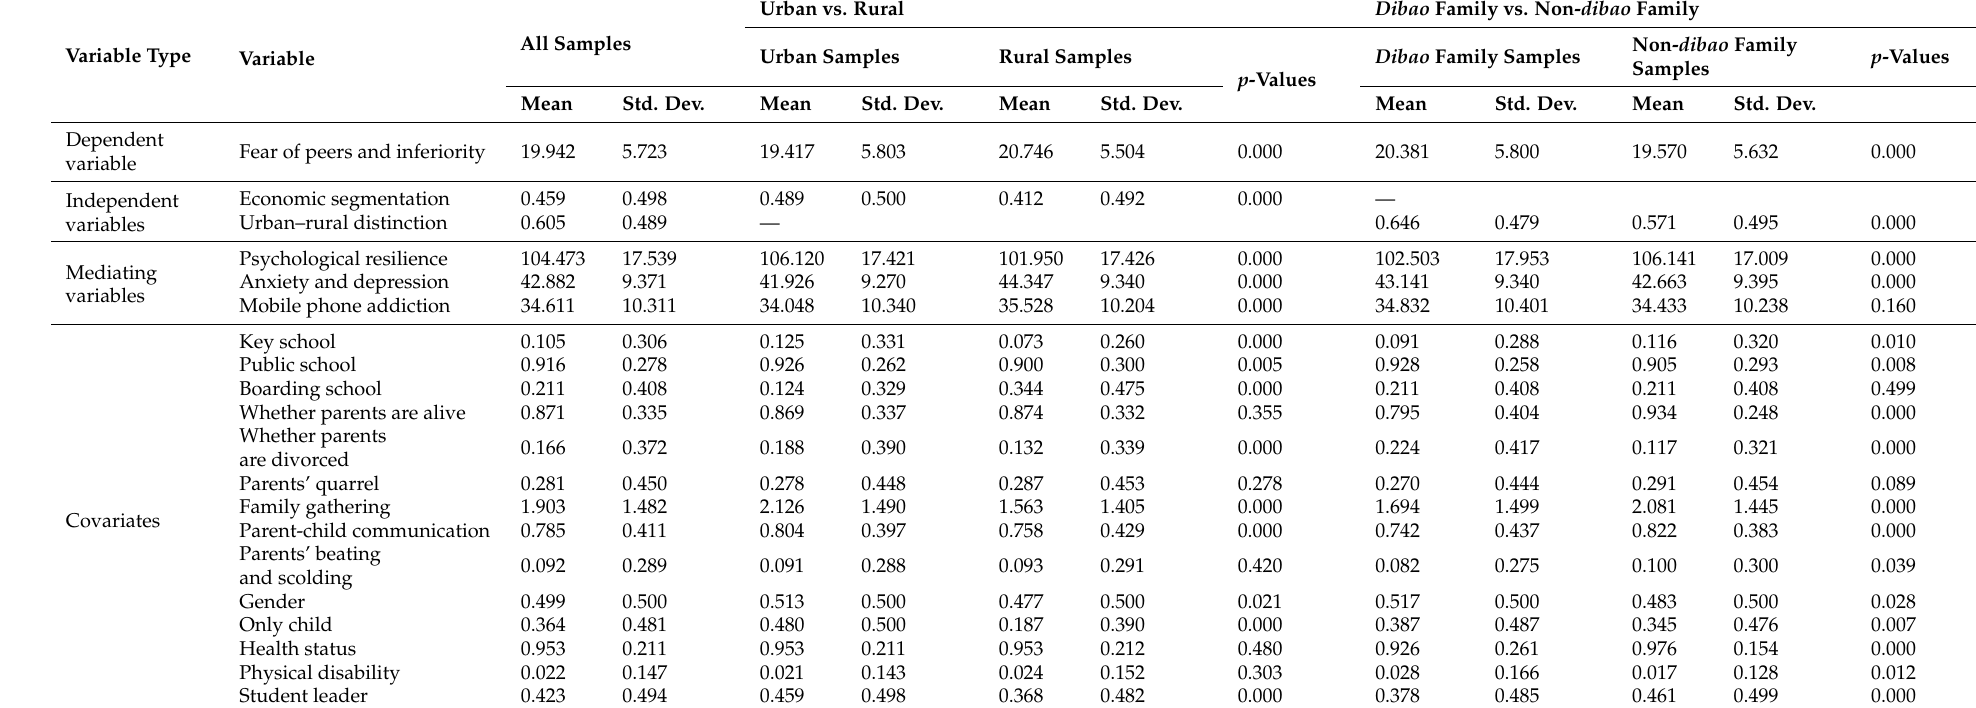
Table 1. Differences in the characteristics of the two group of